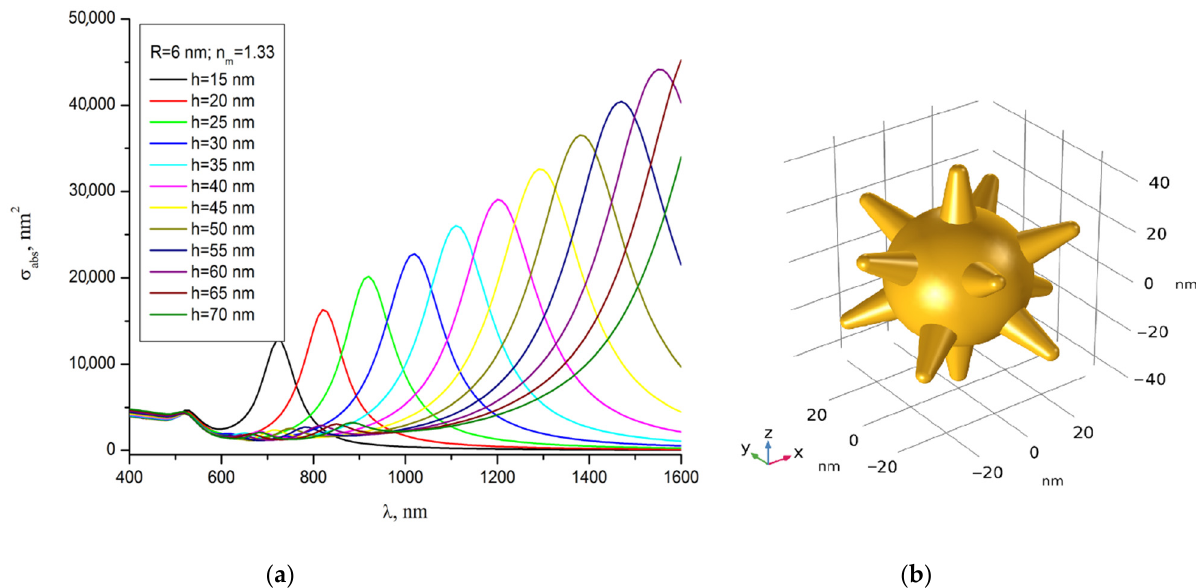
Figure 3. Calculated absorption cross-section spectra depending on the length h of the tips of GNS in water: the GNS is irradiated with laser light linearly polarized along the axis of one of the tips ( a ). Determined geometric model of the GNS: the core diameter is 50 nm, the length h of the conical tips is 19 nm, the diameter of the base of the tips is 12 nm, the radius of the tip end is 3 nm, the number of tips is 12 ( b ).